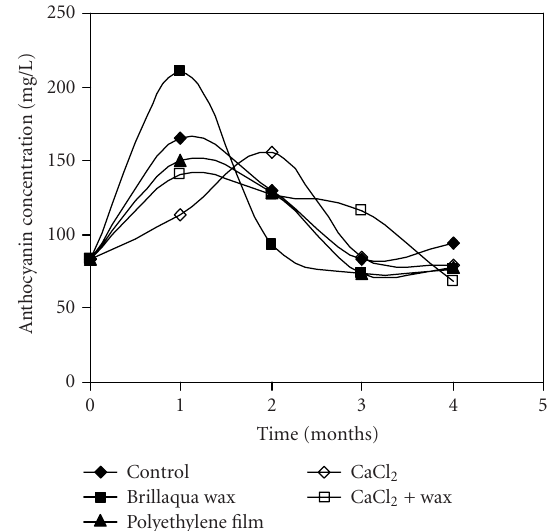
Figure 2. Evolution of total anthocyanin concentration in juice of the “Assaria” pomegranate fruits, during storage at 5 ◦ C, cal- culated from standard curves of Dp3,5; Dp3; Cy3,5; Cy3, Pg3,5, and Pg3. Total amount of anthocyanins in the samples was cal- culated as the sum of the mean of individual